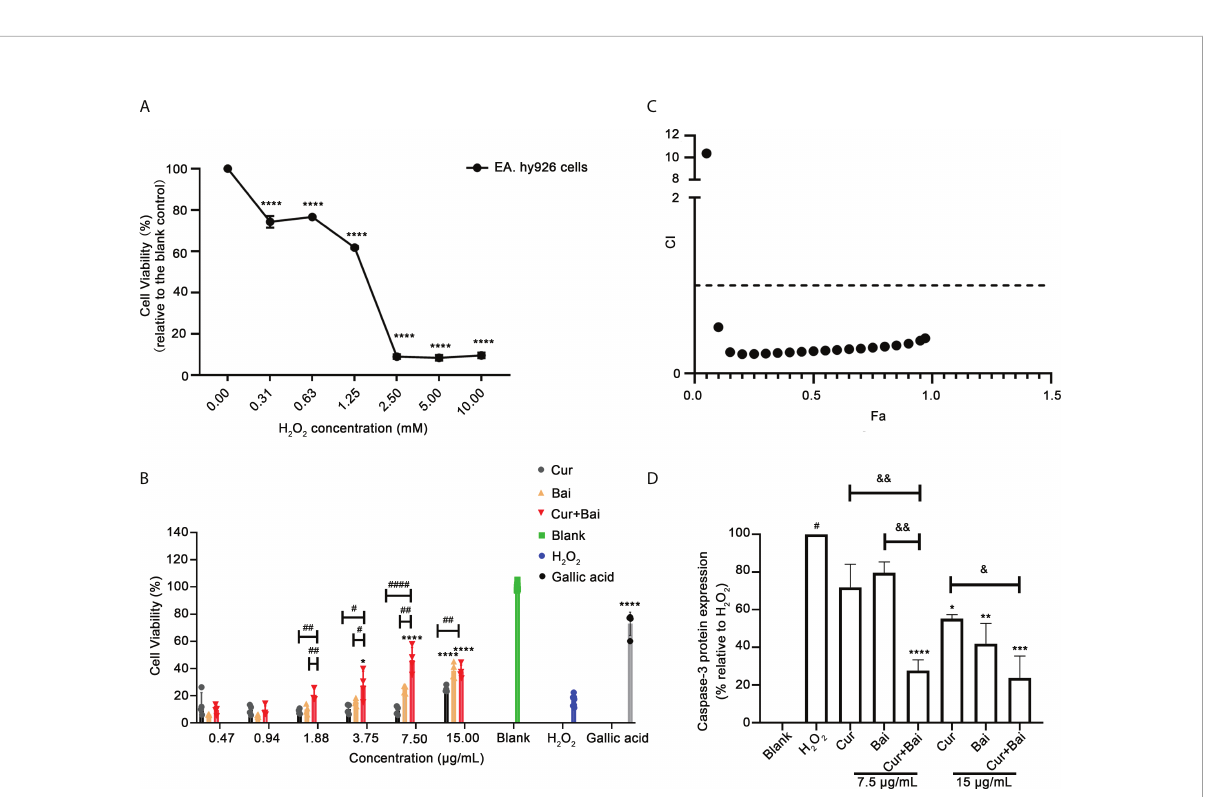
FIGURE 1 Synergistic activity of combined Cur andBai in restoringH 2 O 2 impaired cell viability in EA. hy926cells assessed by Alamar Blue assays. (A) H 2 O 2 dose- dependentlyreduced cell viability in EA. hy926 cells by Alamar Blue assay.**** p <0.0001 vs. H 2 O 2 concentration=0.00mMin EA. hy926cells. (B) Pretreatment ofCur, Bai,or Cur+Bai (1:1, w/w ) restored the cell viability ofEA. hy926cells against the stimulation ofH 2 O 2 at 2.5mMassessed by Alamar Blue assay.Gallicacid was used as a comparative reference. The effectof Cur+Bai in restoring the impaired cellviability was signi fi cantly greaterthan that of Cur orBai at 1.62, 3.25, 7.50 and 15 m g/mL. * p <0.05,**** p <0.0001 vs. H 2 O 2 only. # p <0.05, ## p <0.01, #### p <0.0001 vs. Cur or Bai individual treatment. (C) Synergistic interaction of Cur+Bai in restoring cellviability analysed by CI-Fa curve inEA. hy926cells. Fa represents the